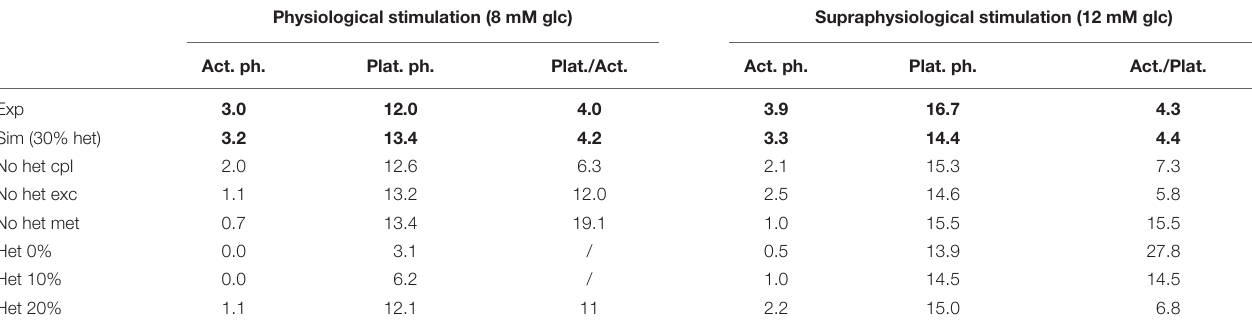
TABLE 1 | Activity time during physiological and supraphysiological